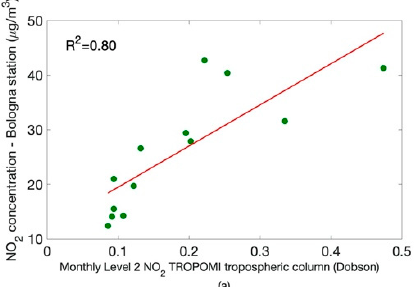
Figure 20. Same as Figure 7, but now the data have been processed with the nearest neighbor technique combined with an ordinary averaging filter. combined with an ordinary averaging